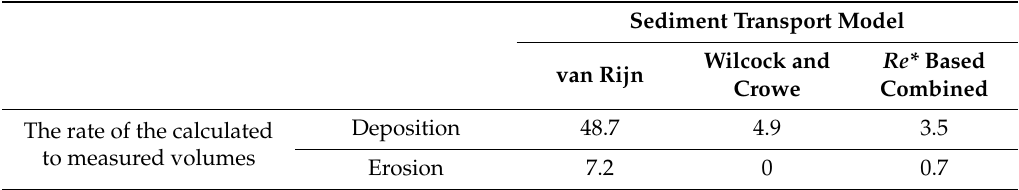
Table 2. The average daily volume changes for calculated ( ∆ V c ) and measured ( ∆ V m ) volume ratio values ∆ V c / ∆ V m for region D . A value of 1 would indicate the perfect